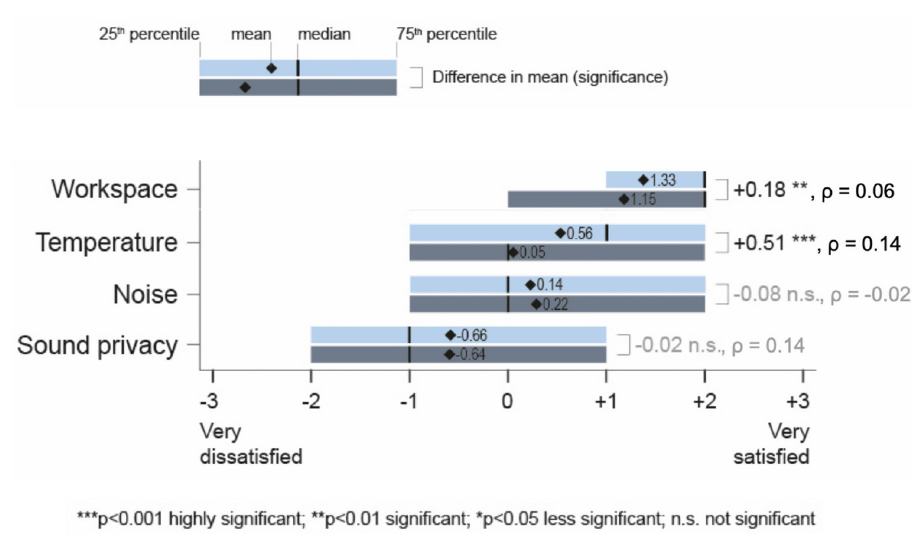
Fig 1. Boxplot for occupant satisfaction with workspace, temperature and acoustics in 60 radiant and all-air buildings. The differences in mean values (radiant–all-air) statistical and practical significance (effect size) of this difference are indicated on the